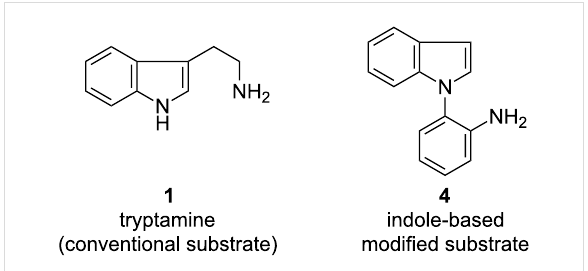
Figure 1: The two Pictet–Spengler substrates employed in the TCT catalyzed cyclization.